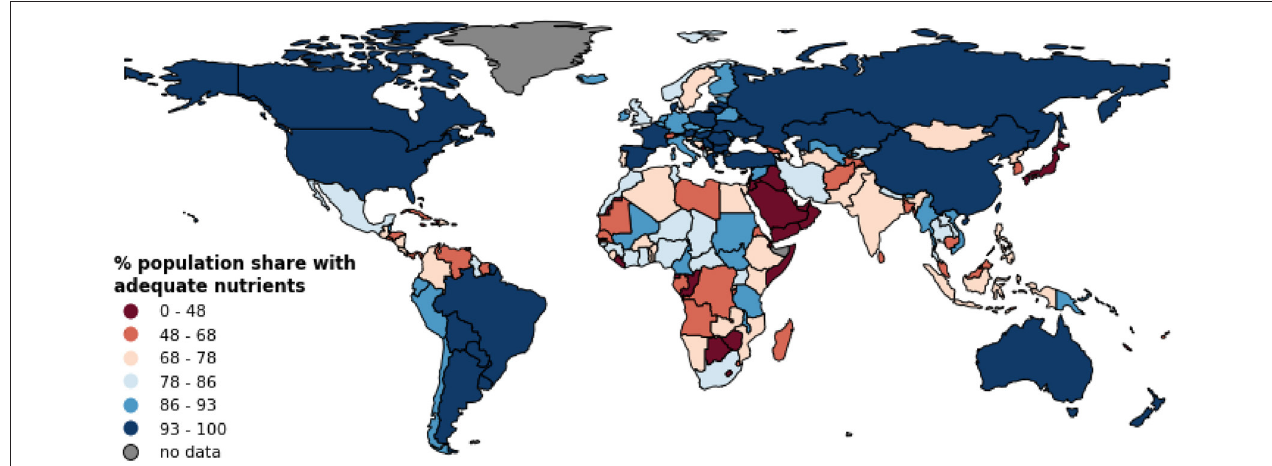
FIGURE 3 | Population share with adequate nutrients (PAN) from the national food production. Symbology is based on quantiles classification method. See Supplementary Table S4 for PAN scores per country per nutrient.